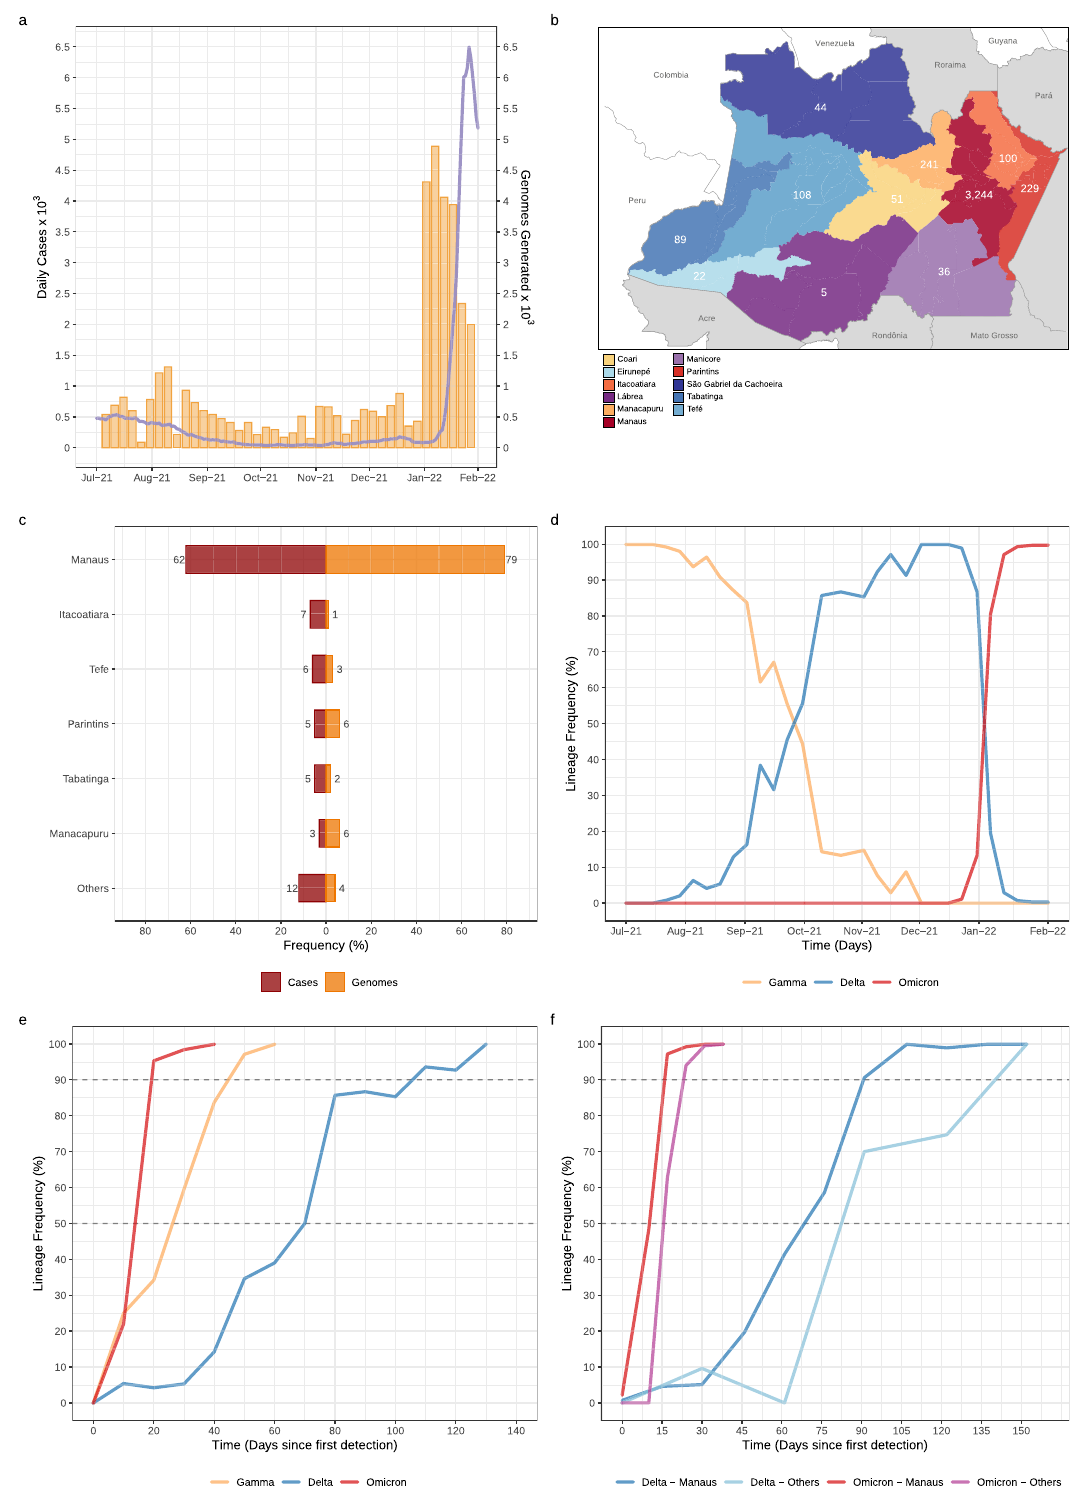
Fig. 1 | Temporal and geographic distribution of SARS-CoV-2 cases and gen- omes in Amazonas state. a Rolling average (7-day) of daily new SARS-CoV-2 con fi rmed cases in Amazonas (solid line) and the number of SARS-CoV-2 genomes sequenced in this study (yellow bars) between 1st July 2021 and 31st January 2022. b Map of Amazonas state showing regions covered by the SARS-CoV-2 genomes generated in this study. Numbers represent genomes generated for each region. c NumberofSARS-CoV-2con fi rmedcasesandSARS-CoV-2genomesfromdifferent Amazonian regions between 1st July 2021 and 31st January 2022. d – e Frequency of VOCs Gamma, Delta, and Omicron BA.1 among SARS-CoV-2 positive samples